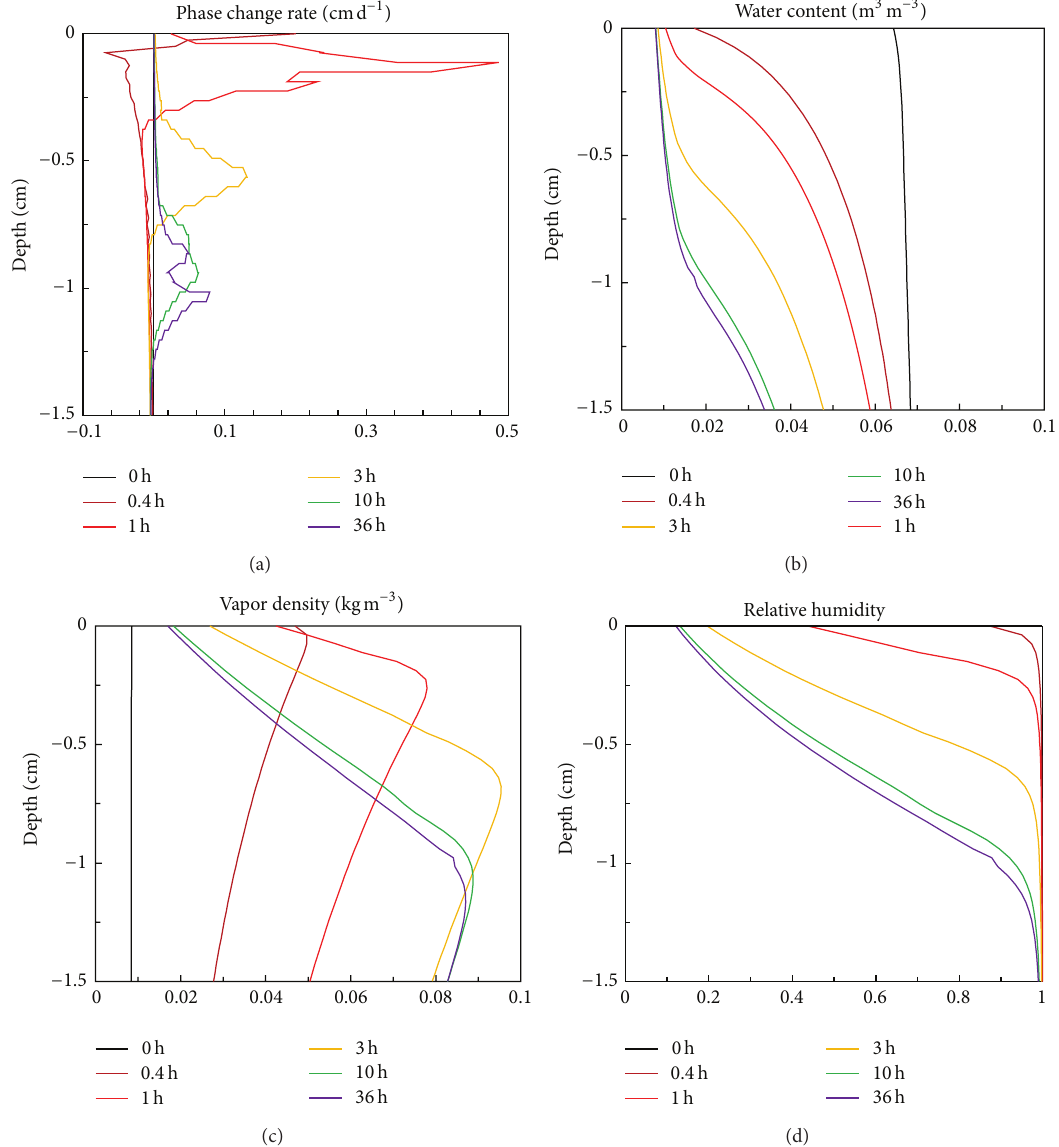
Figure 5: (a) Subsurface evaporation rate, (b) water content, (c) vapor density, and (d) relative humidity profiles at selected times above 1.5 cm